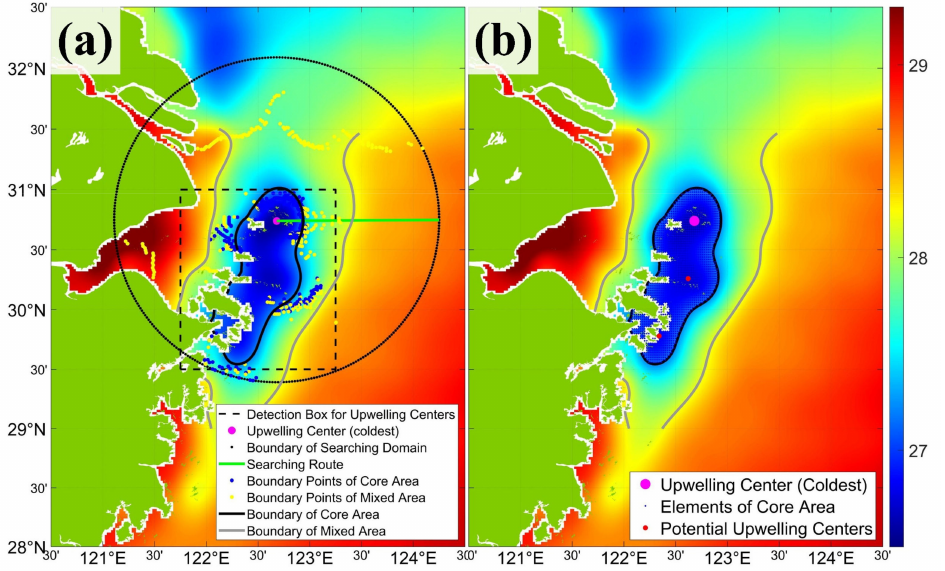
Figure 3. ( a ) Schematic of the upwelling detection algorithm; ( b ) distribution of potential upwelling points and pixels of core